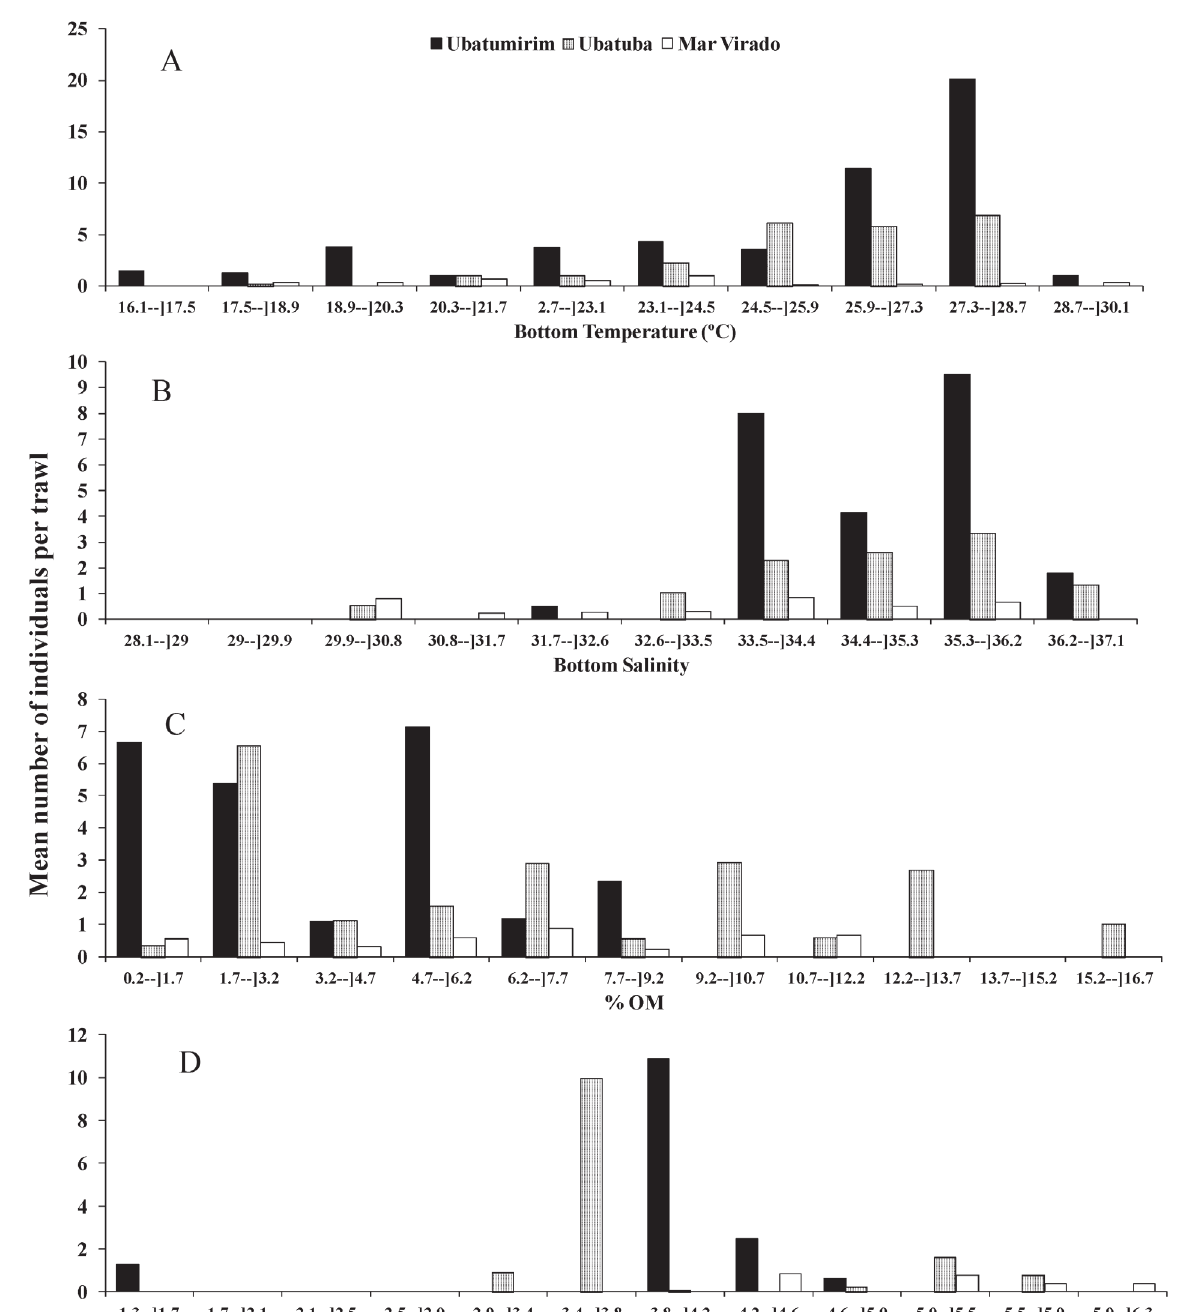
Figure 7. Hexapanopeus paulensis . Abundance of individuals, distributed according to environmental factors classes (A: bottom temperature; B: bottom salinity; C: percentage of organic matter; D: phi) at Ubatumirim, Ubatuba and Mar Virado, from January 1998 to December